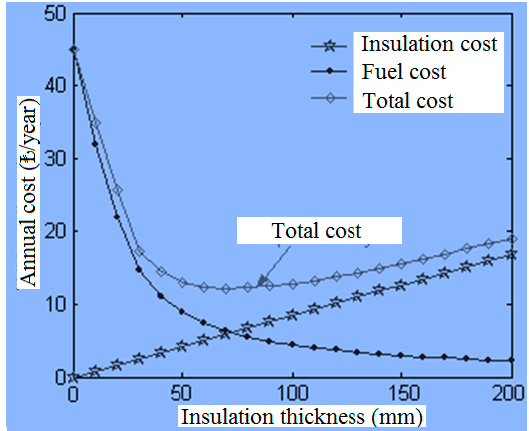
Figure 4. Total cost and impact of insulation thickness.